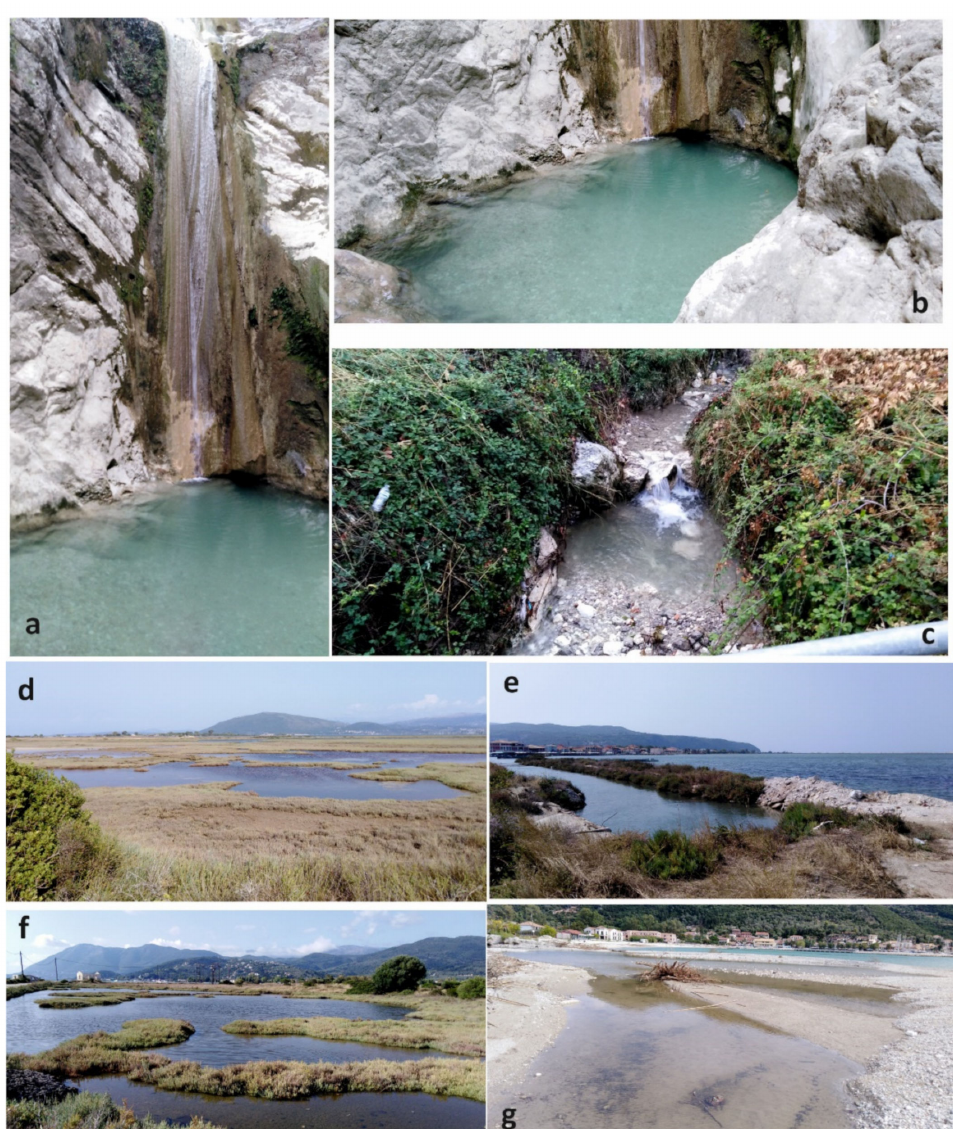
Figure 5. Selected geosites on Lefkas island, for coding see Figure 4: ( a , b ) Dimosaris waterfalls (L09); ( c ) Katourlou river (L12); ( d , e ) Lefkas lagoon (L03); ( f ) Alexander saltpans (L06); ( g ) estuaries at Ponti-Vassiliki beach (L15). Photos ( a – g ) courtesy E. Spyrou. Gorges: Roupakias gorge (L10) represents a deep V-shaped intramountainous